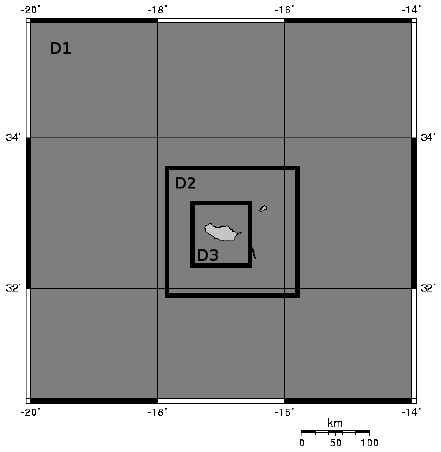
Table 2. Weather Station information used to evaluate model